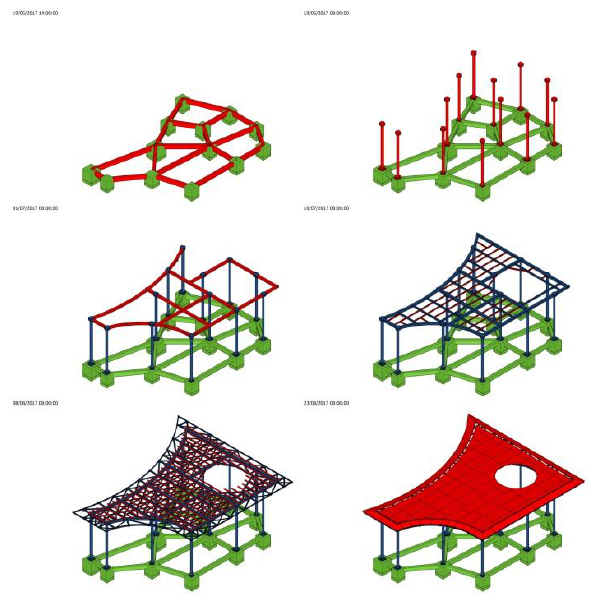
Figure 11. Building phases in